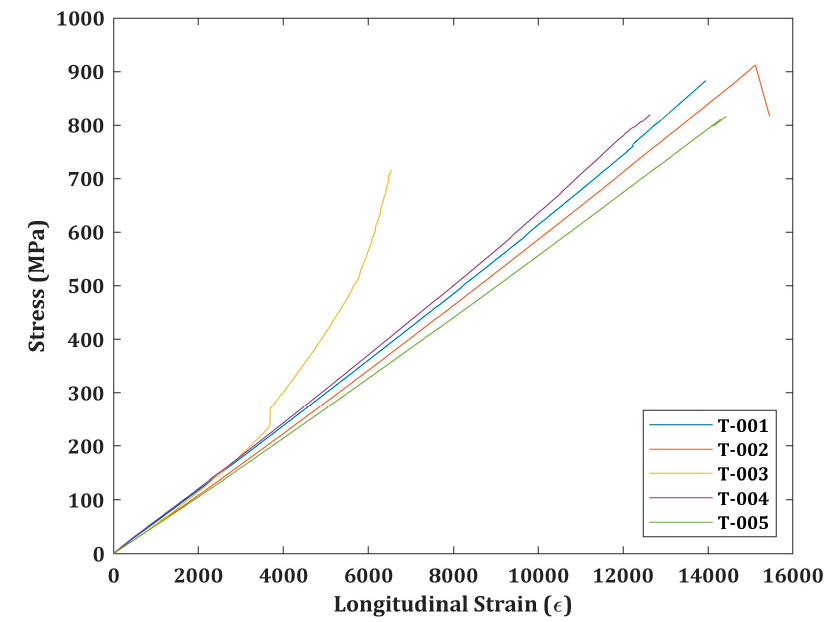
Figure A1. Stress–strain (longitudinal) curves of the tensile tests.